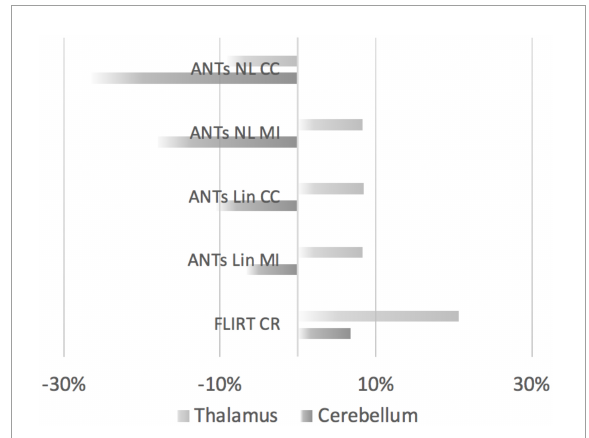
TABLE 6 Post hoc comparisons for mean ranks: fetal thalamic segmentations.